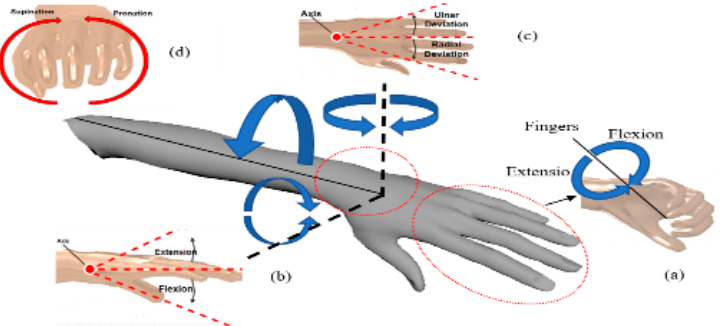
Figure 1. Overview of Fingers and Wrist Rehabilitation Mechatronic System (FWRMS) targeted movements; ( a ) Fingers flexion/extension; ( b ) Wrist flexion/extension; ( c ) Wrist Radial/ulnar deviation; (d) Forearm pronation/supination.